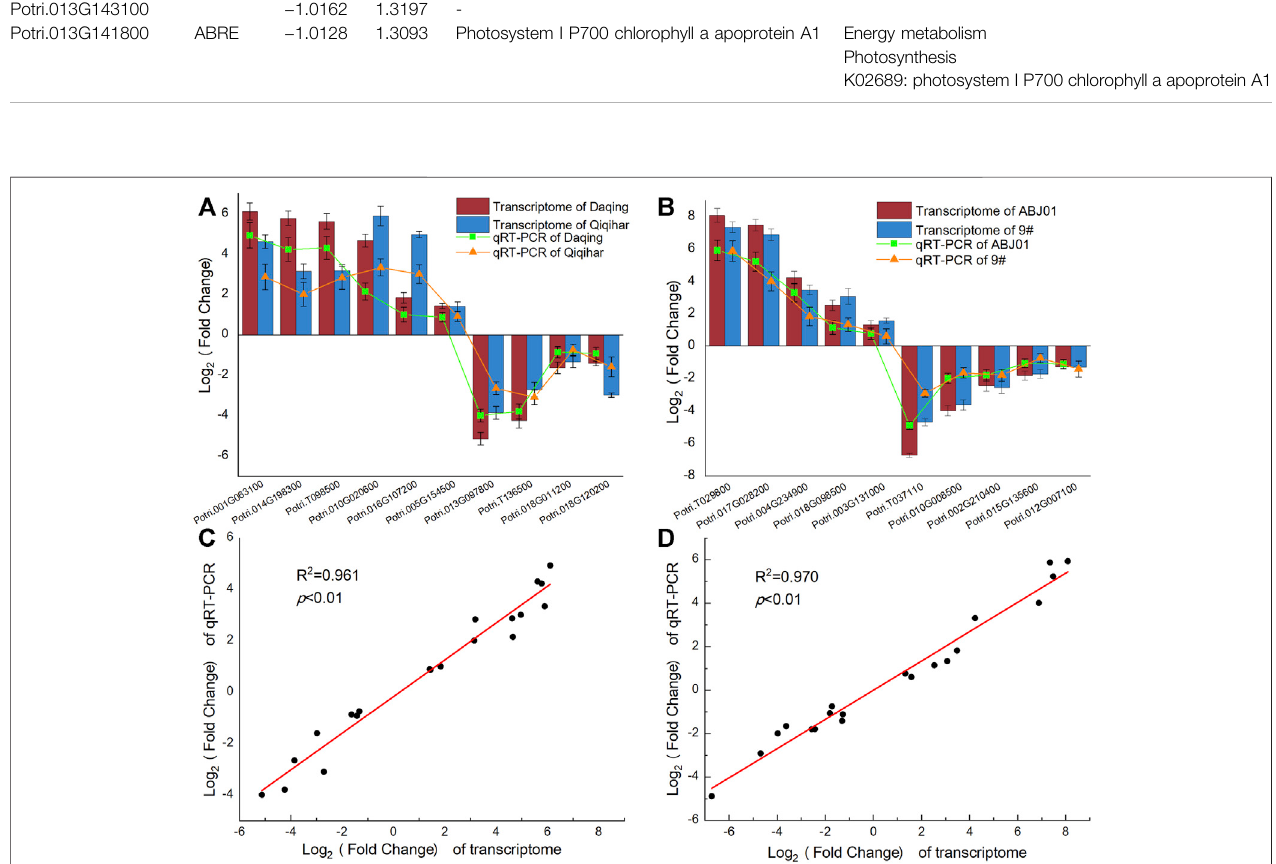
FIGURE11| Expressionpatternof20DEGsbyqRT-PCRand transcriptomesequencing. (A) .Log 2 Foldchange(ABJ01/9#) inDaqing andQiqihar; (B) .Log 2 Fold change (Daqing/Qiqihar) in ABJ01 and 9#; (C) correlation o Log 2 f fold change (ABJ01/9#) in Daqing and Qiqihar analyzed by RNA-seq (x-axis) with data obtained using qRT-PCR (y-axis); (D) correlation of Log 2 fold change (Daqing/Qiqihar) in ABJ01 and 9# analyzed by RNA-seq (x-axis) with data obtained using qRT-PCR (y-axis).